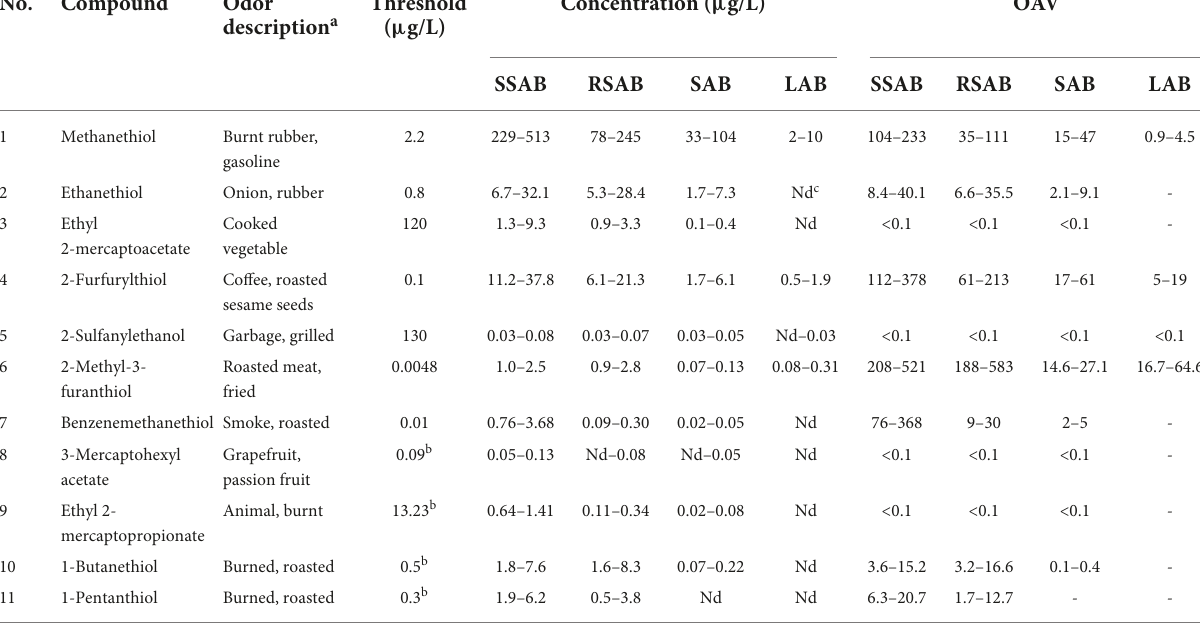
TABLE 3 The thiol concentrations in different aroma types Baijiu and their corresponding odor activity values (OAVs) range. No.